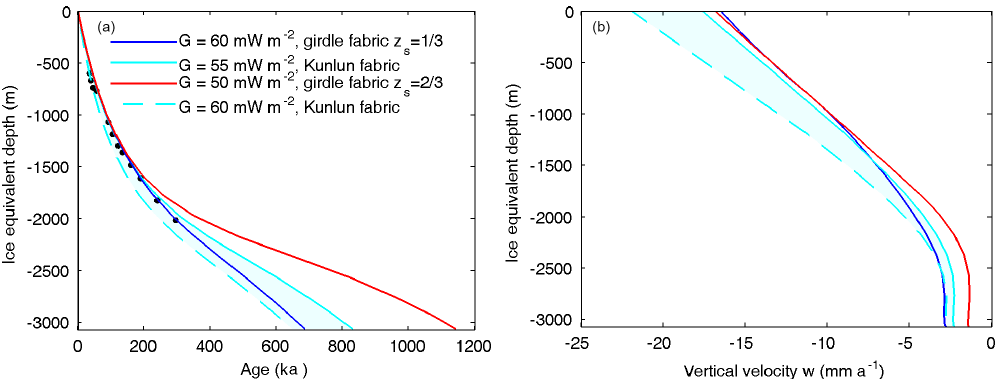
Figure 3. The best-fit simulations (solid lines) at Kunlun station using geothermal heat fluxes of 50, 55, and 60mWm − 2 . Modeled age– depth profile (a) and vertical velocity – depth profile (b) . The black points denote the dated radar internal reflection horizons tracked from the Vostok ice core site, using a 37m firn correction (based on the EDML ice core density profile, Ruth et al., 2007) subtracted from the radar depths to convert to the ice-equivalent model scale. The shaded cyan band shows an envelope of acceptable fits to the radar isochrones and age profile with depth, however the dashed (60mWm − 2 ) line likely has surface velocities that are too